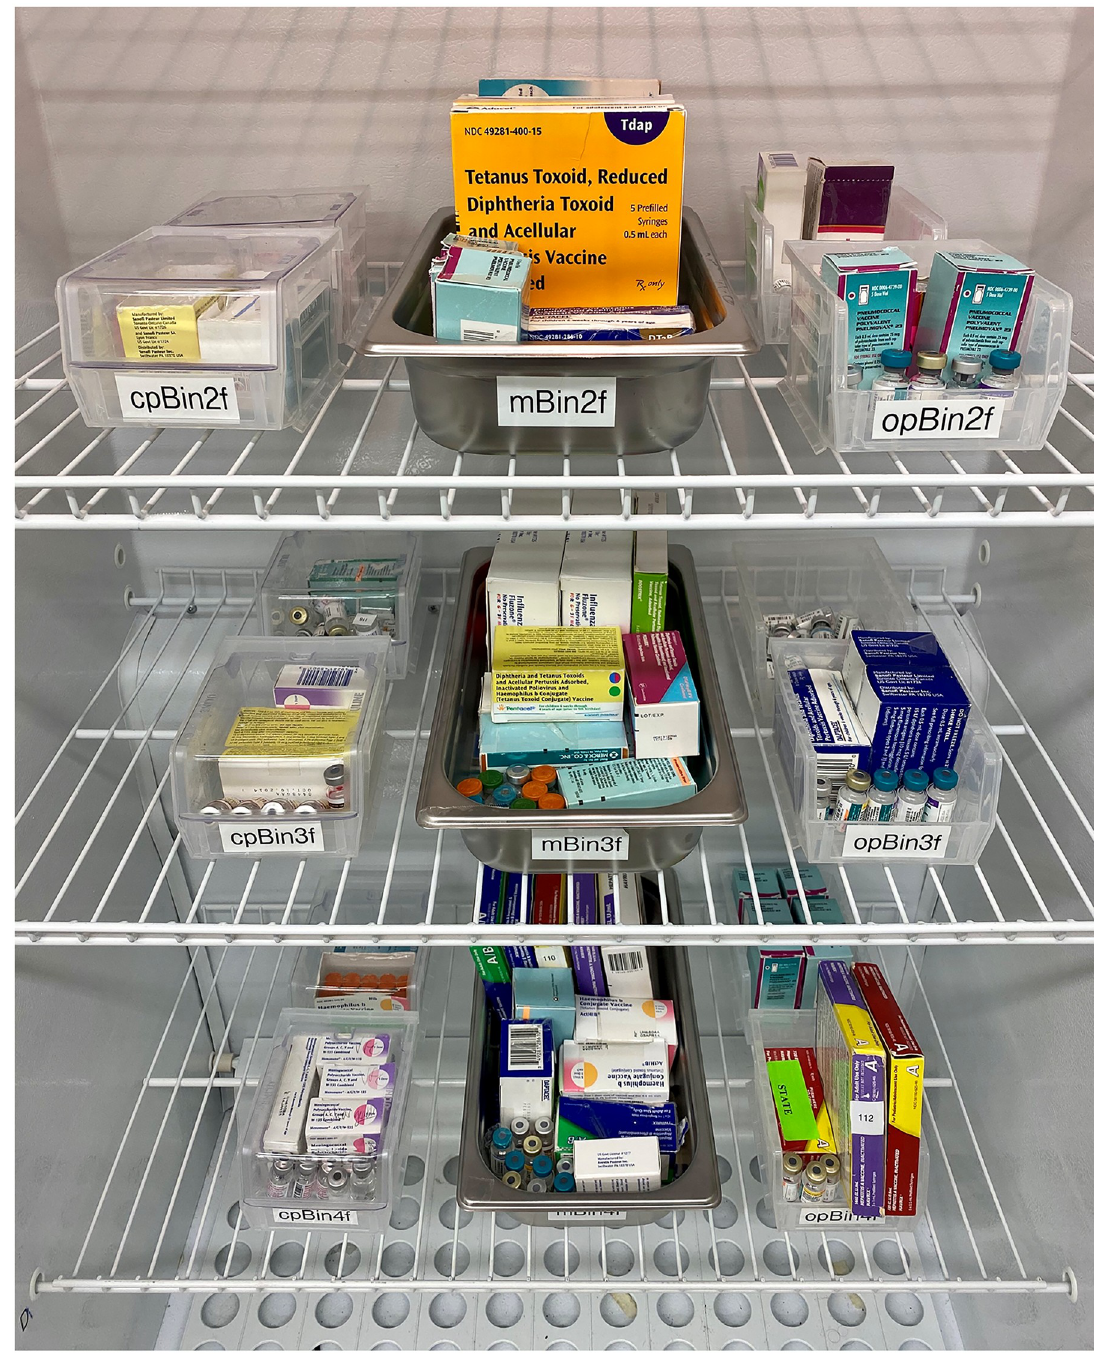
Fig 1. Stored vaccine setup. Each shelf was outfitted with five storage containers (left to right): two closed plastic bins, one large metal tray, and two uncovered plastic bins. The storage containers were filled with a mix of boxed and unboxed vaccines. The top shelf (not shown) was kept free of stored vaccines to allow for water bottle placement in this